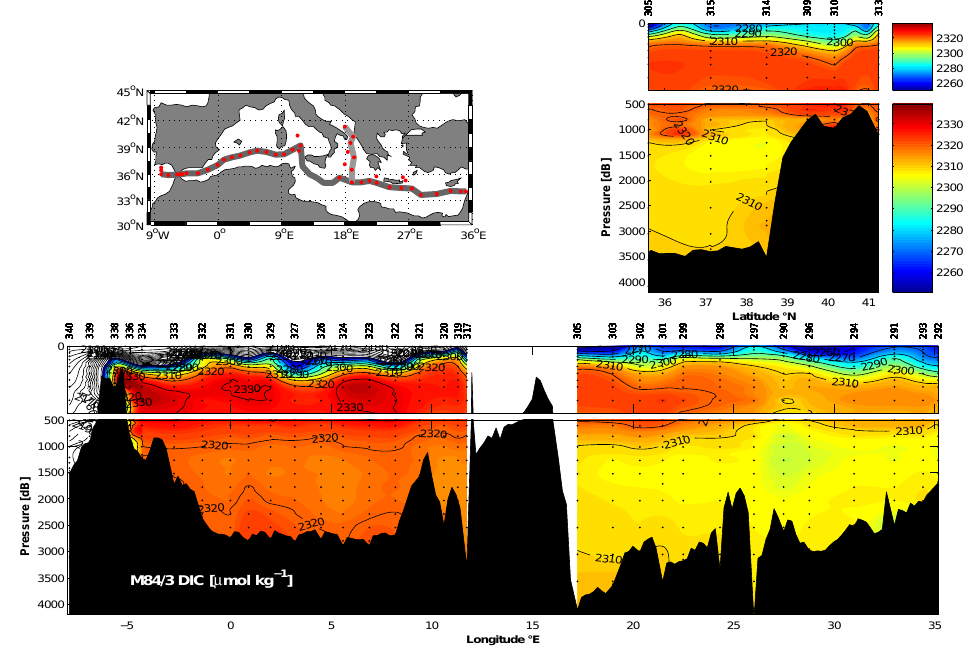
Fig. 6. As in Fig. 5 but for DIC (µmolkg − 1 ).